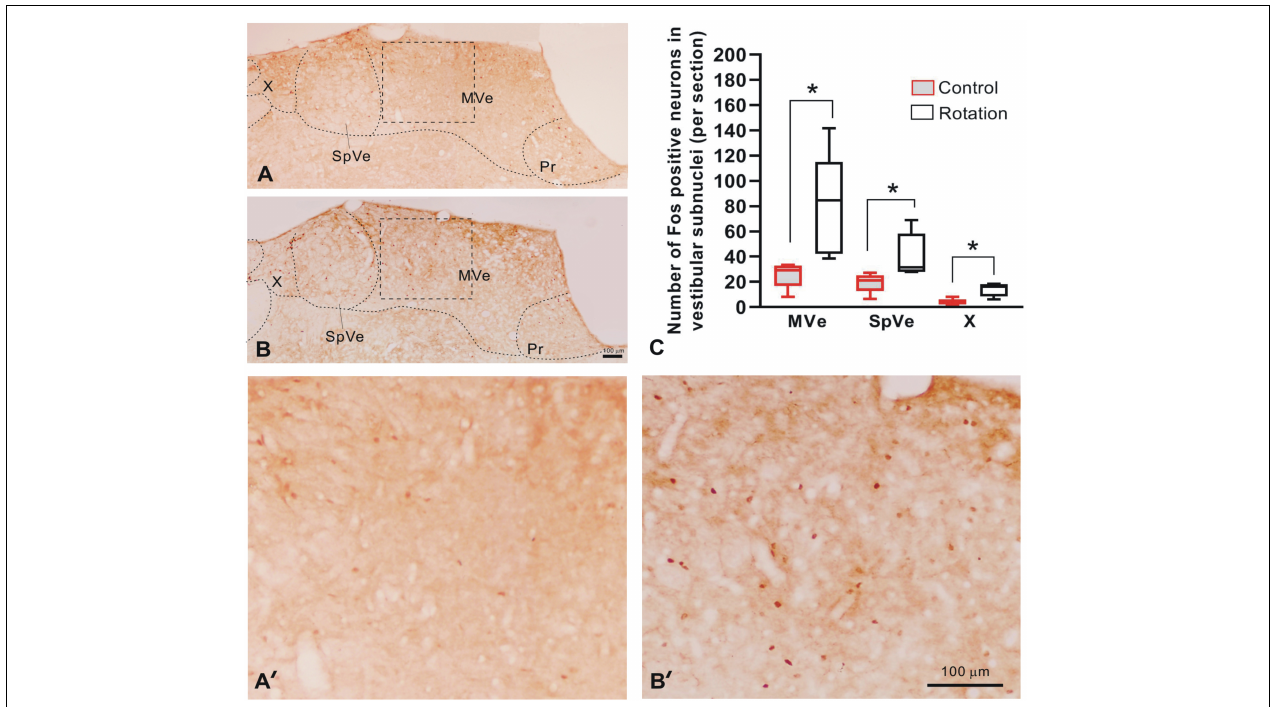
FIGURE 5 | The Fos-IR in vestibular nucleus complex as compared between control (pseudo-stimulation) and rotated rats. (A,B) The digital images of brain sections from control and rotated rats, respectively, showing Fos-IR in vestibular subnuclei MVe, SpVe, and X. (A’,B’) Amplification of the rectangular areas (MVe) in panels (A,B) delimited by dashed lines, respectively. (C) The graph showing the increased number of the Fos-IR neurons per section in unilateral MVe, SpVe, and X of rotated rats, as compared with the control ( *p < 0.05, n = 5, Mann–Whitney U -test). Bars = 100 µ m in panels (B,B’) . MVe, medial vestibular nucleus; Pr, prepositus nucleus; SpVe, spinal vestibular nucleus; X, X